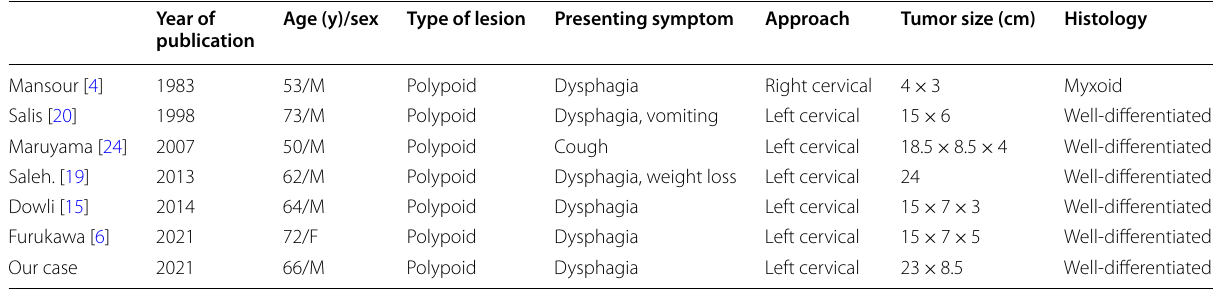
Table 1 Literature review of seven cases, including our case, of esophageal liposarcoma that were removed only through a cervical